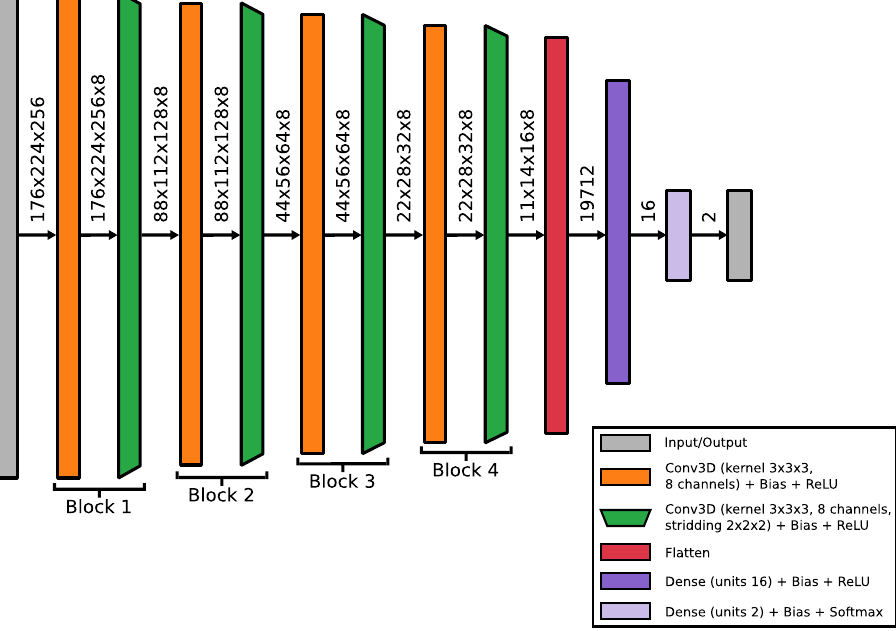
Figure 1. Structure of the 3D classifier network combining a single convolutional layer (kernel 3 × 3 × 3 , 8 channels) with a down-convolutional layer (kernel 3 × 3 × 3 , 8 channels, stridding 2 × 2 × 2 ) as the main building block. The overall network stacks 4 of these main building blocks followed by two fully connected layers (16 and 2 units) with totally 0.3 million trainable parameters. Each layer is followed by a Rectified Linear Unit (ReLU) nonlinearity, except for the output layer where a Softmax activation is applied. Dimensionalities between layers describe the tensor size after each network